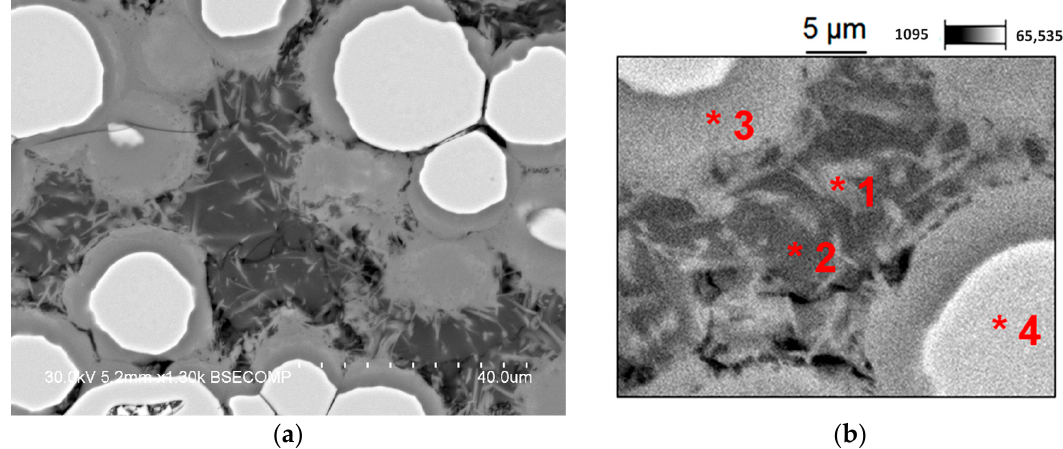
Figure 3. An area of the cross-section of the composite obtained by SPS of Al–50 vol.% Fe 66 Cr 10 Nb 5 B 19 ( a ). SPS conditions: temperature—570 °C, holding time—3 min, applied pressure—40 MPa. The points (1, 2, 3 and 4) in which the energy dispersive spectroscopy (EDS) analysis was conducted are marked in ( b ). BSE images. Table 1. Concentration of elements in points 1–4 marked in Figure 3b. Data for the Al–50